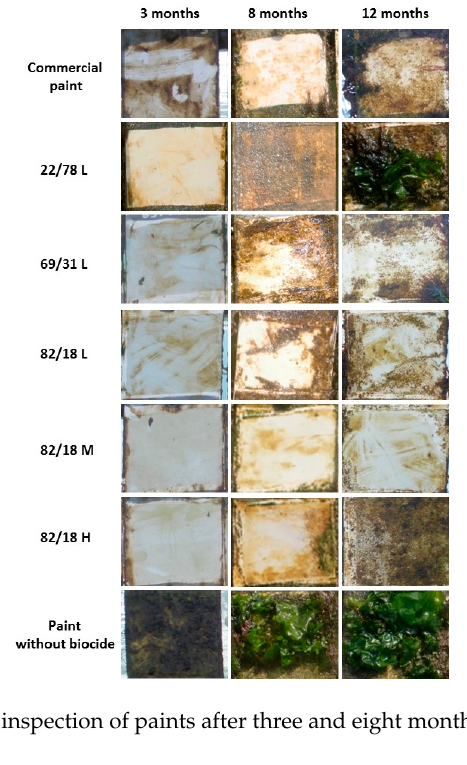
Figure 4. Visual inspection of paints after three and eight months of immersion.